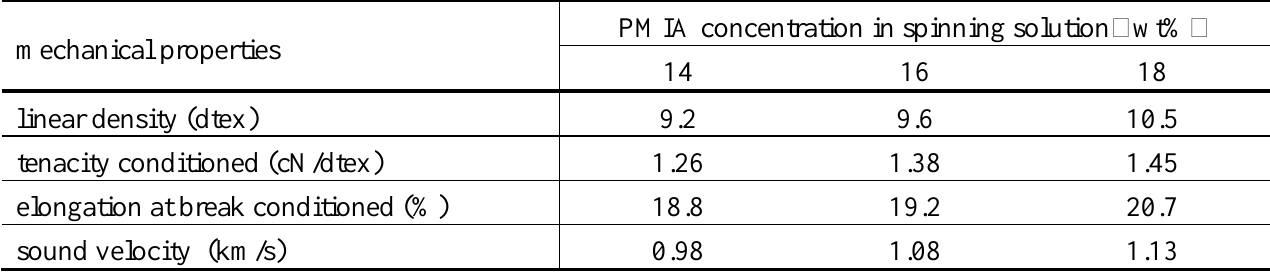
Table 1. Effect of PMIA concentration in spinning solution on mechanical properties of as-spun fibers.